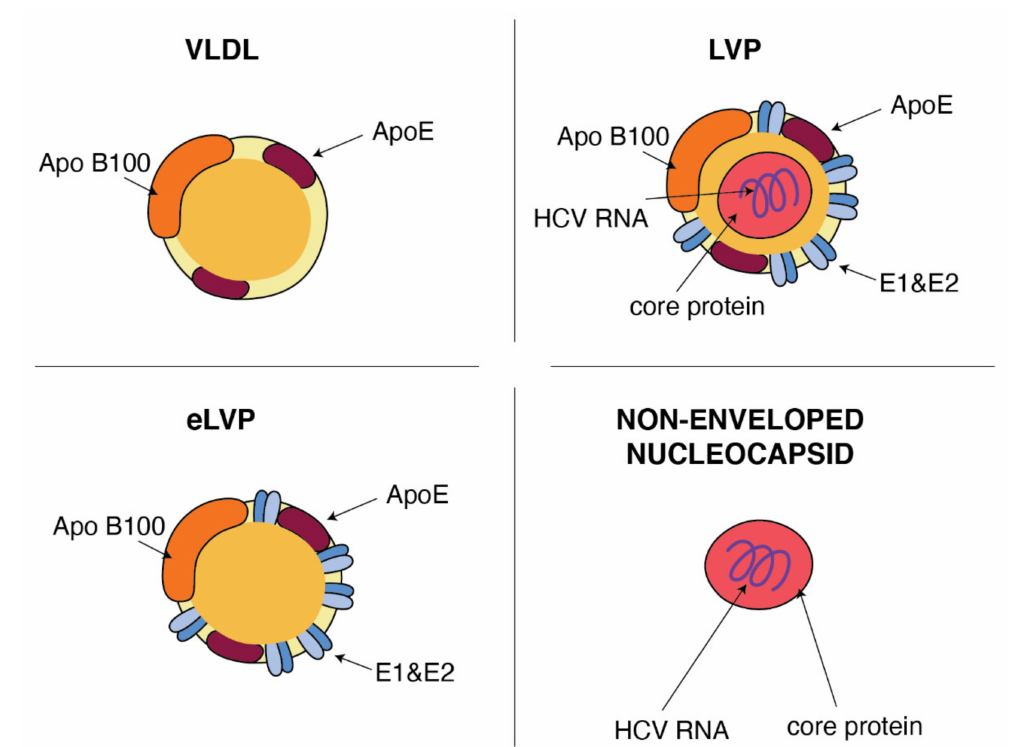
Figure 2. Similarities between VLDL and HCV particles. ApoB and ApoE apolipoproteins classically associated with host VLDL particles are very useful components of HCV particles: lipo-viral particles (LVP) and empty lipo-viral particles (eLVP). An additional component that appears in the lipid envelope of these two HCV particles is a heterodimer composed of viral E1 and E2 envelope glycoproteins. Capsid, formed by the viral core protein, containing the positive HCV RNA strand may be surrounded by the lipid envelop with embedded E1 and E2 glycoproteins, such as in the case of LVP, or may form a non-enveloped viral particle also presented in the blood of HCV-infected